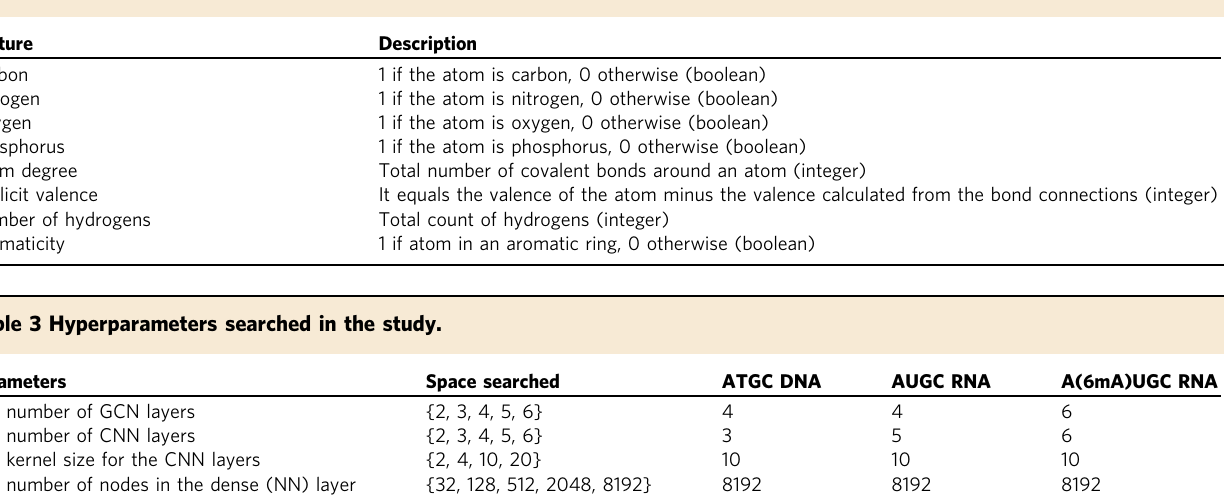
Table 2 Atom chemical properties included in the study.